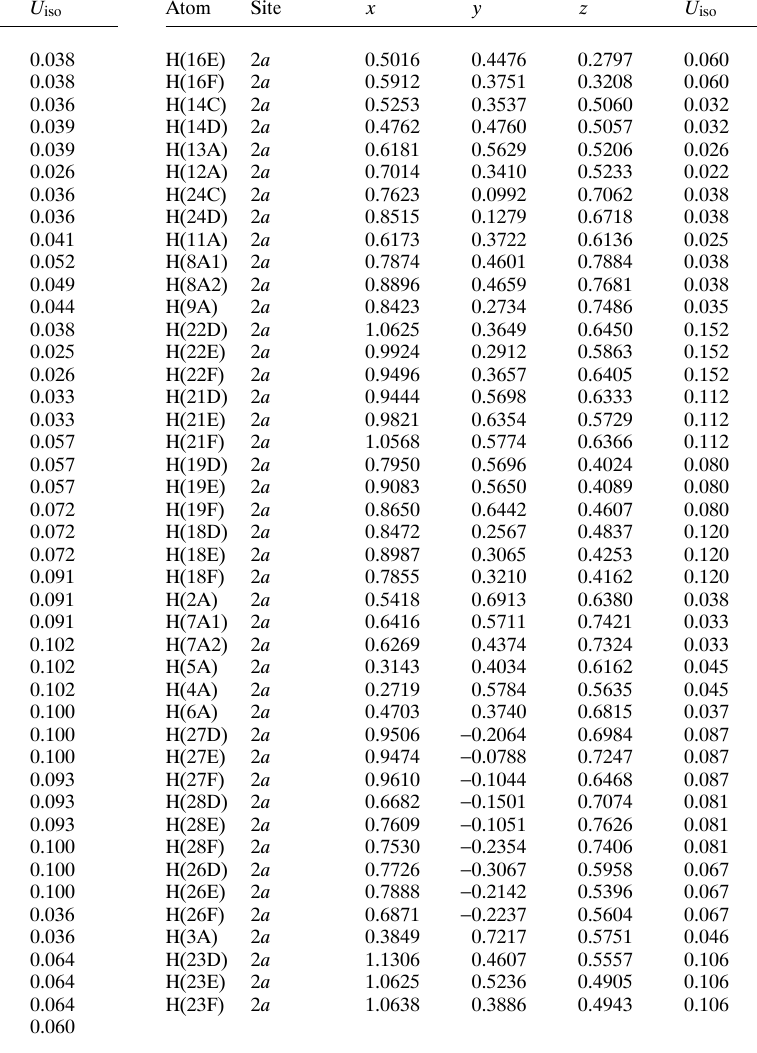
Table 2. C ontinued .